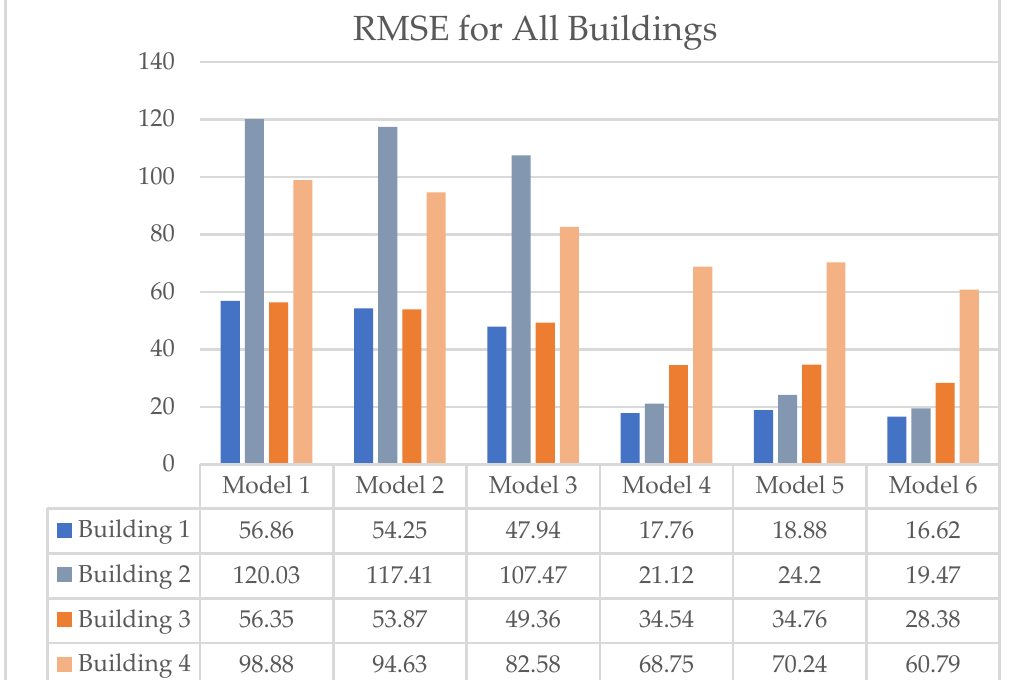
Figure 9. Average RMSE values for all buildings in Greensboro, NC.